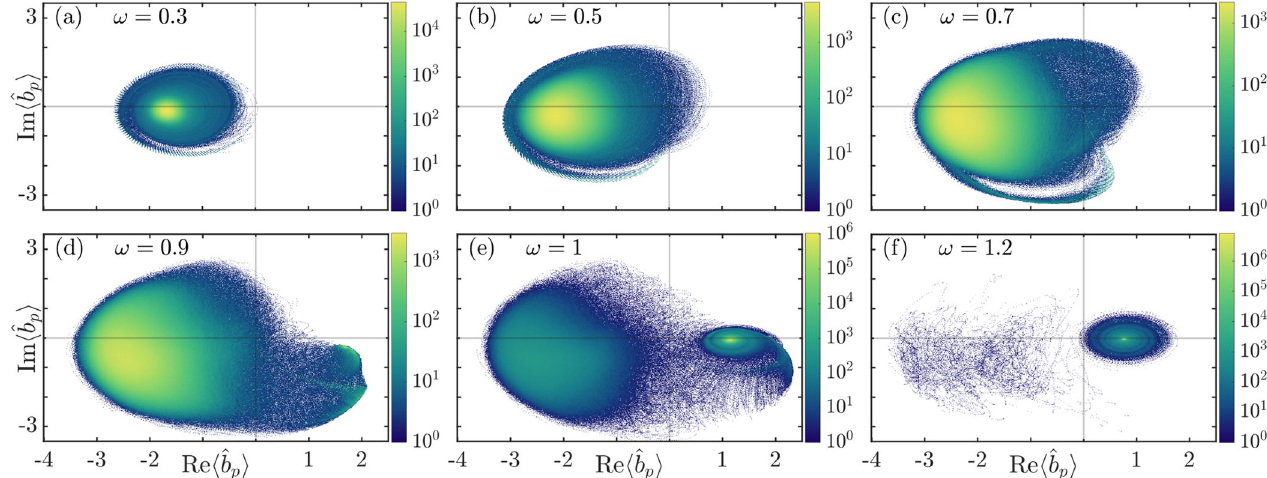
Fig. 3 Visualization of the quantum trajectories. We employ a 2D histogram showing the full-time evolution of 2000 trajectories, presented in log scale, with the quantum trajectories projected to the resonant plane. Each trajectory starts from the vacuum state 0 j i , corresponding to the point (0,0) at the intersection of the two grid lines. The evolution and interplay of the various fi xed points are clearly visible as the frequency of the drive increases, including the emergence of the chaotic attractor replacing the bright fi xed point and the nucleation of the dim fi xed point at higher frequencies. Here u = 0.1, γ = 0.05, and d =